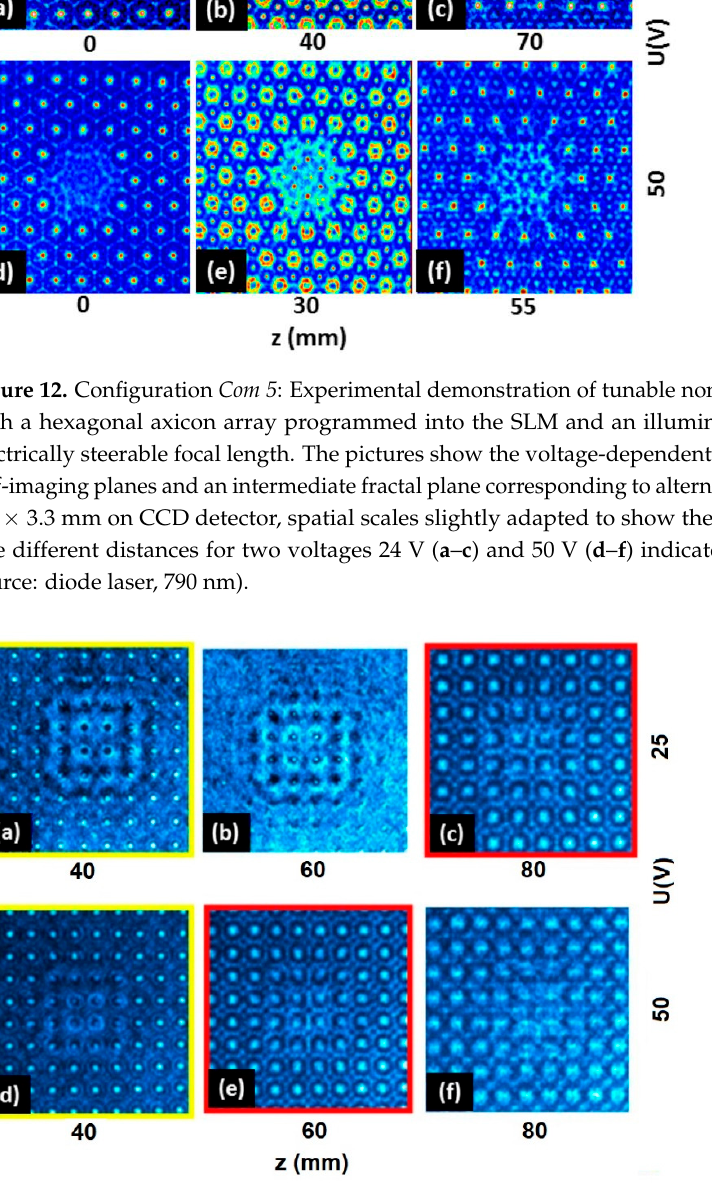
Figure 13. Configuration Com 5 : Experimental demonstration of tunable nondiffracting self-imaging with an orthogonal axicon array: interference patterns at three different distances for two different voltages at the tunable lens (FOV: 3.3 × 3.3 mm on CCD detector, laser source: diode laser, 790 nm). Contrary to Figure 12, different patterns appear at different voltages for equal distances (compare a – c and d – f ).